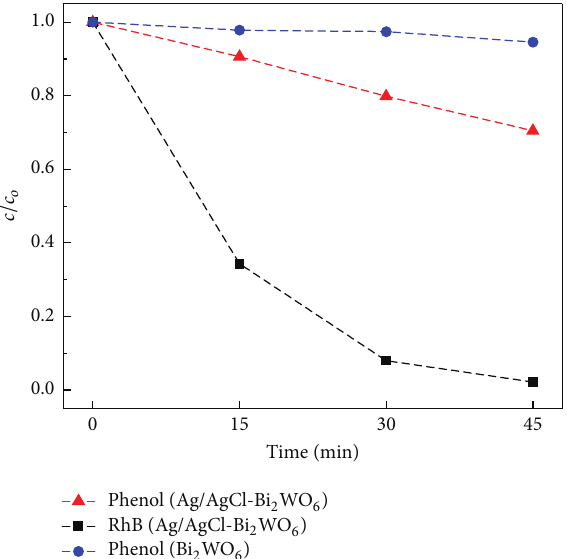
Figure 11: Degradation of phenol (10mg/L) by using Ag/AgCl- Bi 2 WO 6 composite.